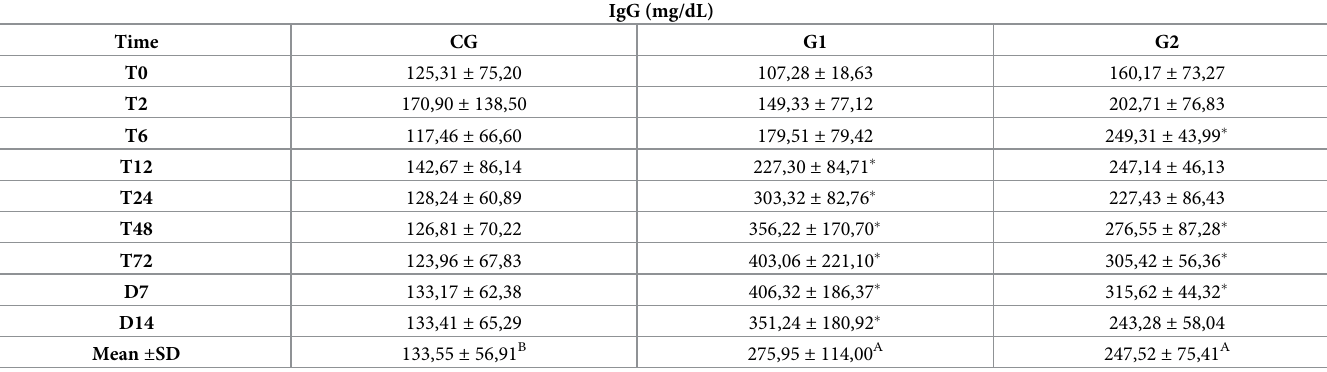
( � ) represent differences compared to baseline time (T0) within the group; Different capital letters represent differences between groups at the same time; p � 0.05.